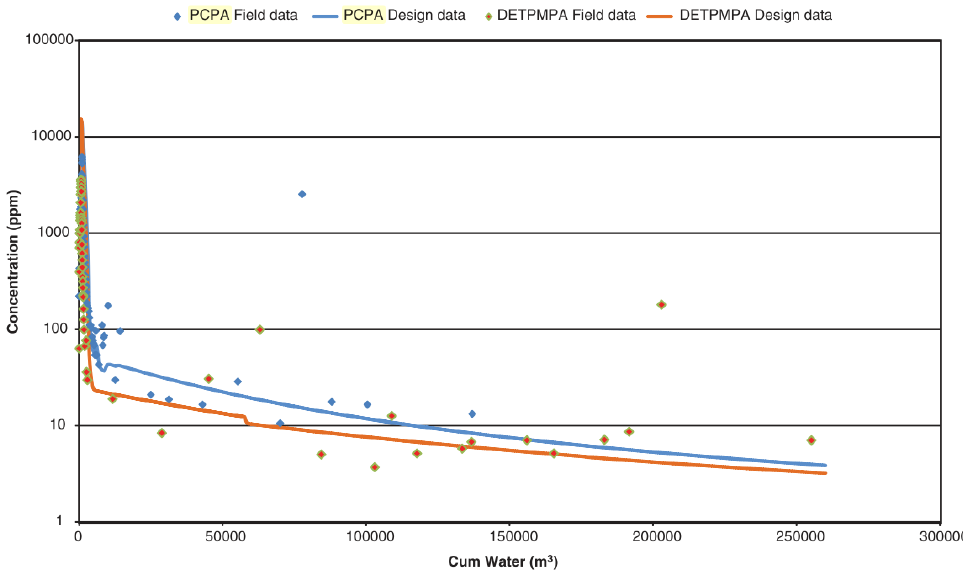
Figure 17. Field returns of incumbent inhibitor Product B and the subsequent field trial with Product A on Well E-22 [ Error! Reference source not found. ].